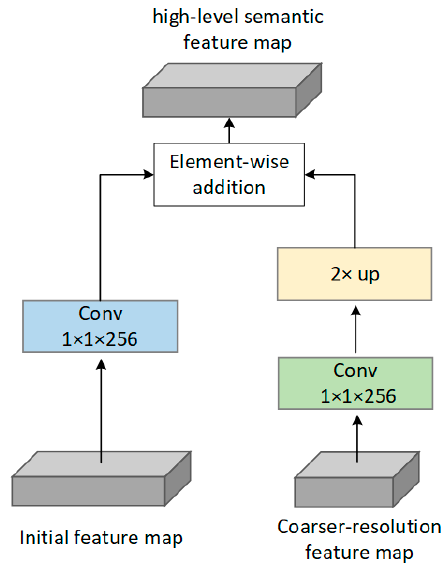
Figure 7. A building block of FPN.